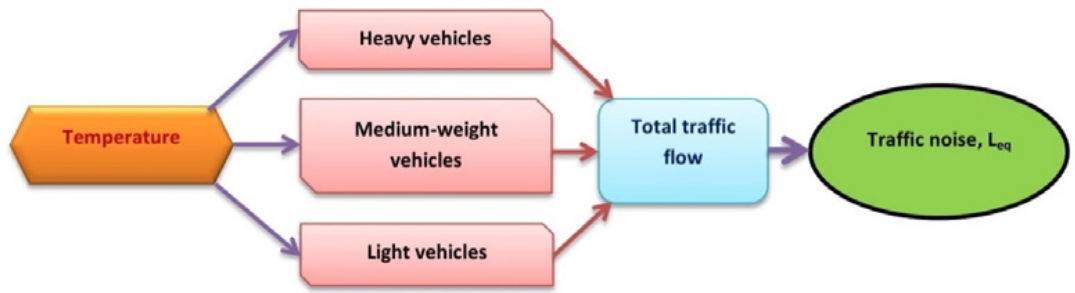
Fig. 1: Example of applying path analysis technique in a noise model by decision makers